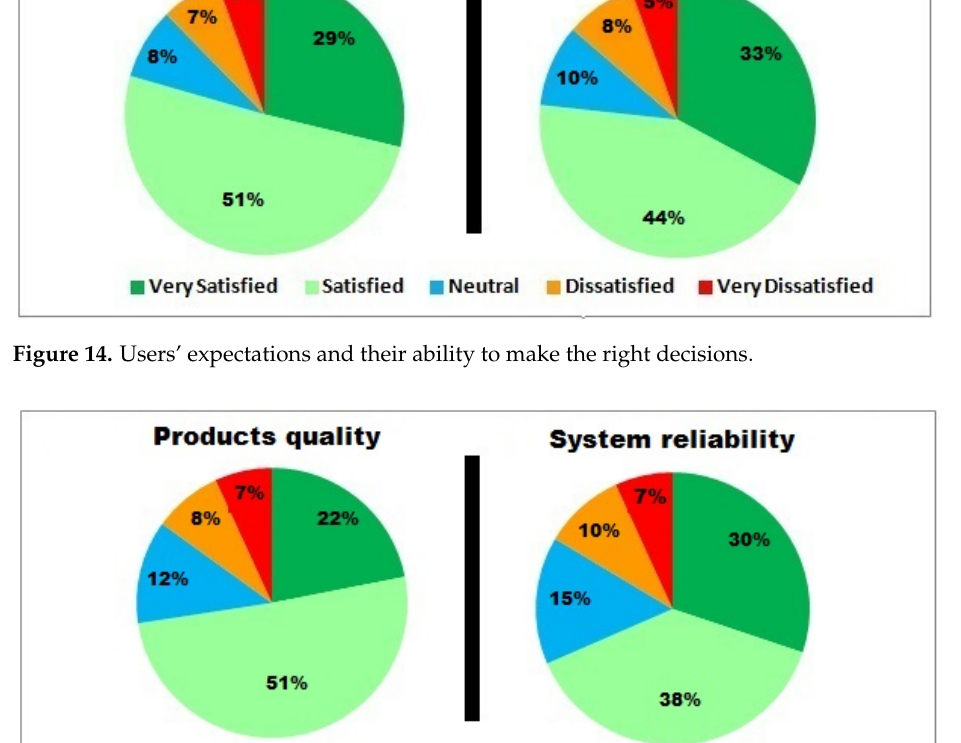
Figure 15. Recommended product quality, and IIoTMS reliability.